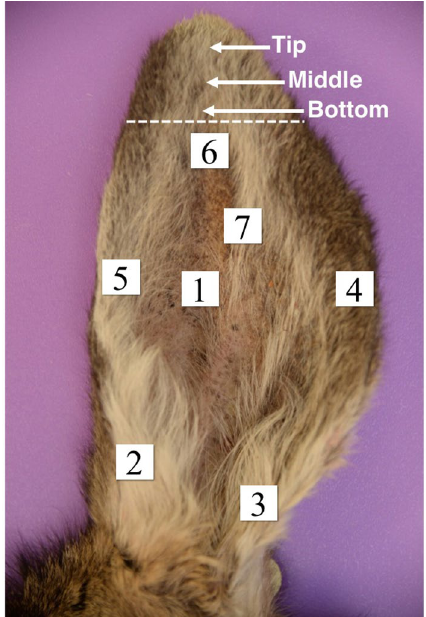
Figure 2. Representative picture of the ear parts from which the skin tissue was collected. The region of the apex of the ear above the dashed line shows areas samples for the initial survey of ear specimens using the original, suboptimal CWD RT-QuIC assay conditions. The numbers below the dashed line indicate areas from which 0.5 cm punches were taken for the analysis shown in Fig.